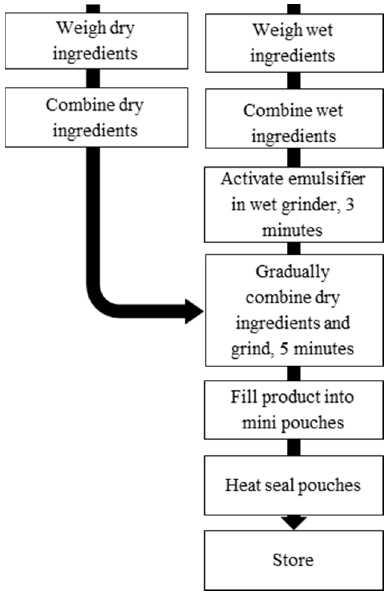
Figure 1. LNS processing flow diagram . Figure 1. Lipid-based nutrient supplements (LNS) processing flow